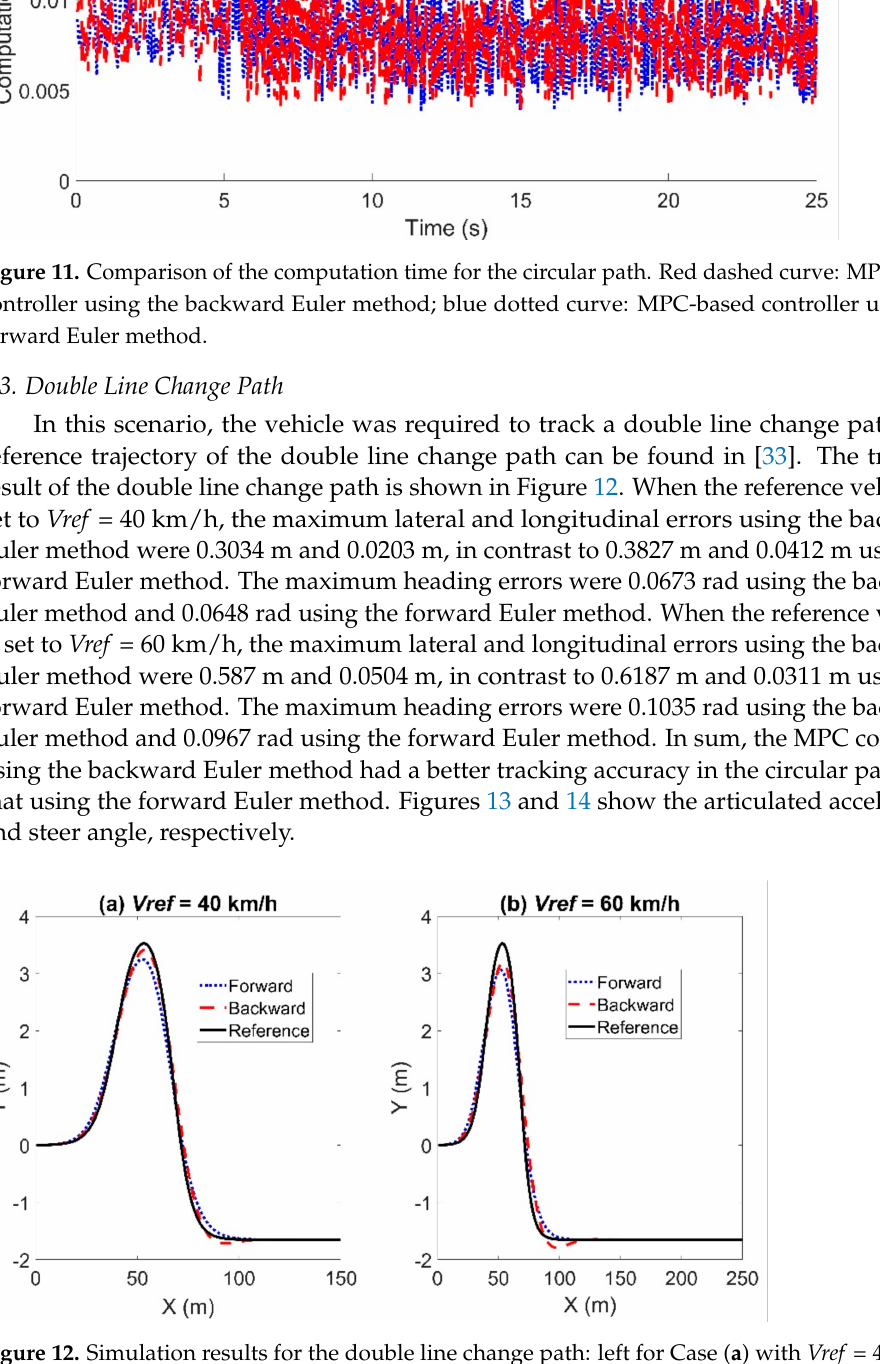
Figure 12. Simulation results for the double line change path: left for Case ( a ) with Vref = 40 km/h and right for Case ( b ) with Vref = 60